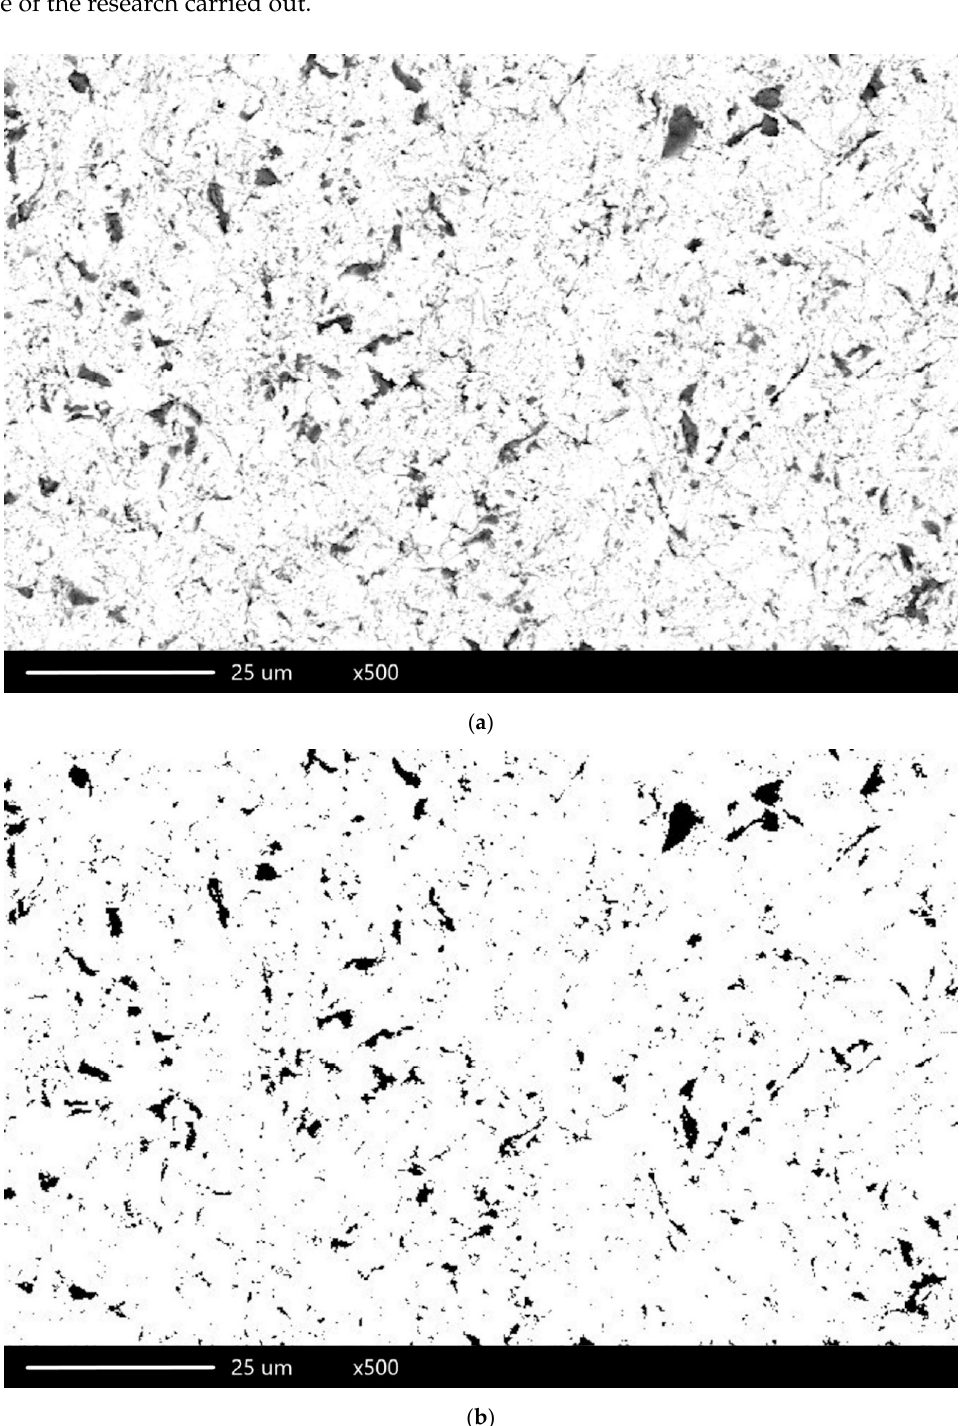
Figure 1. Photograph of the Ni-Cr alloy surface after SiC blasting cleaning size 50 µ m, pressure 0.2 MPa: ( a ) the image before the processing in the program; ( b ) the image after